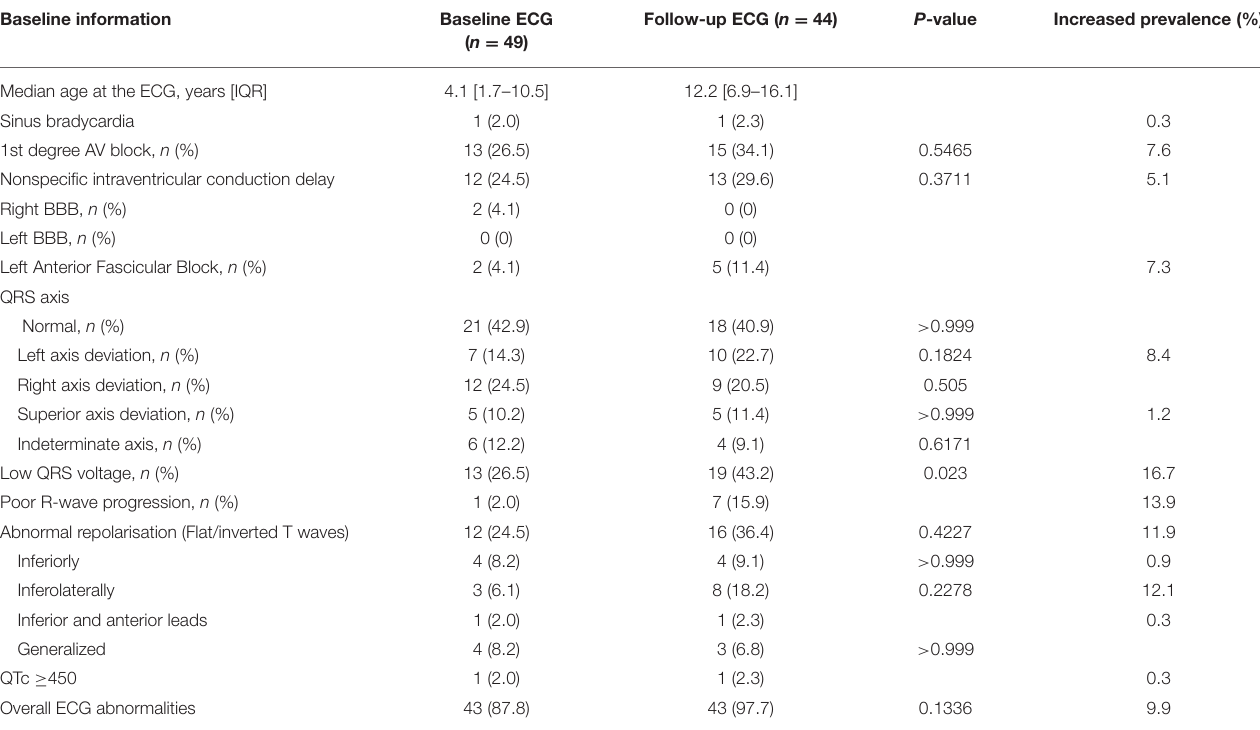
TABLE 2 | Electrocardiographic findings of congenital DM1 patients. Baseline